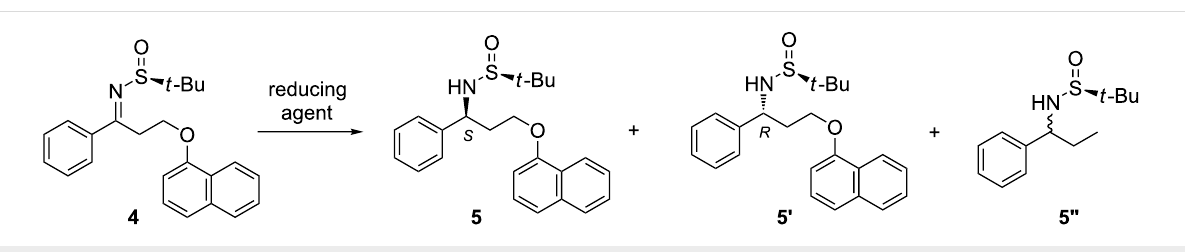
Scheme 1: Asymmetric synthesis of 1 .